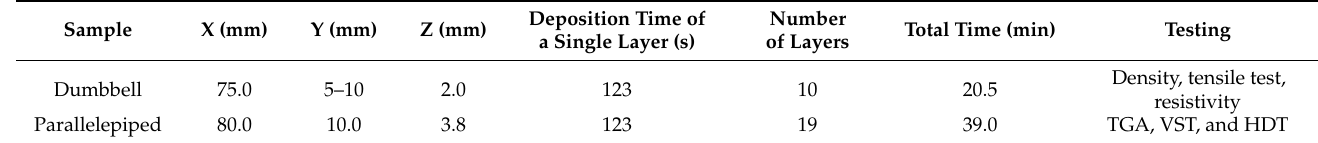
Table 3. Dimensions and processing parameters of FFF